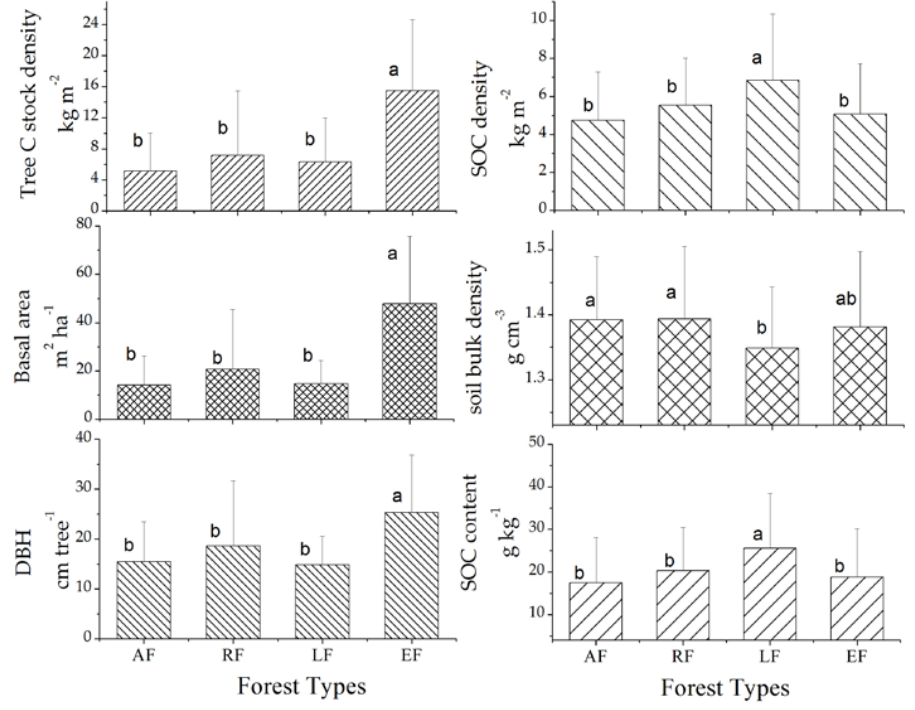
Figure 2. Differences in tree C stock density, basal area, and diameter at breast height (DBH) ( left ), plus differences in soil organic carbon (SOC) density, SOC content, and soil bulk density ( right ) among different forest types in Harbin City. Note: AF, affiliated forest; RF, roadside forest; LF, landscape and relaxation forest; EF, ecological public welfare forest. Error bars showed standard deviation, and lowercase letters (a and b) indicate significant differences ( p < 0.05) based on the one-way ANOVA test statistics. The same letters (a and a, ab) indicate no significant differences, and different letters (a and b) indicate significant differences.